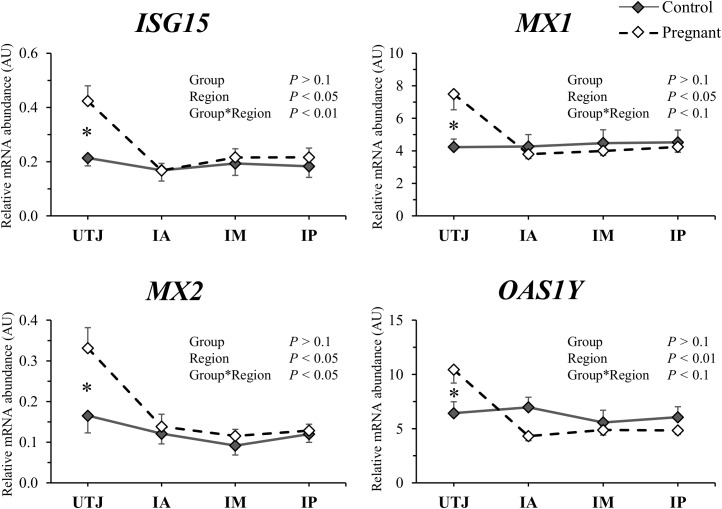
Relative mRNA abundance of interferon-stimulated genes (arbitrary units; AU; mean ± SEM) for control (solid lines) and pregnant (dashed lines) cows in the uterotubal junction (UTJ), anterior (IA), medial (IM) and posterior (IP) regions of the uterine horn ipsilateral to the CL.*P < 0.05 and ˟P < 0.1 denotes that significant differences were reached or approached, respectively, between groups at each specific region.